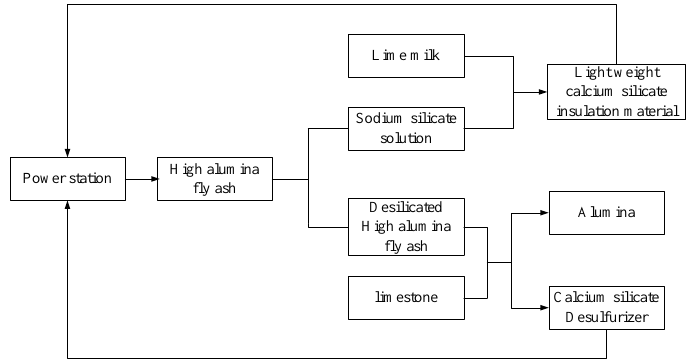
Figure 1. Recycling route of thermal power plant high alumina fly ash (HAFA).